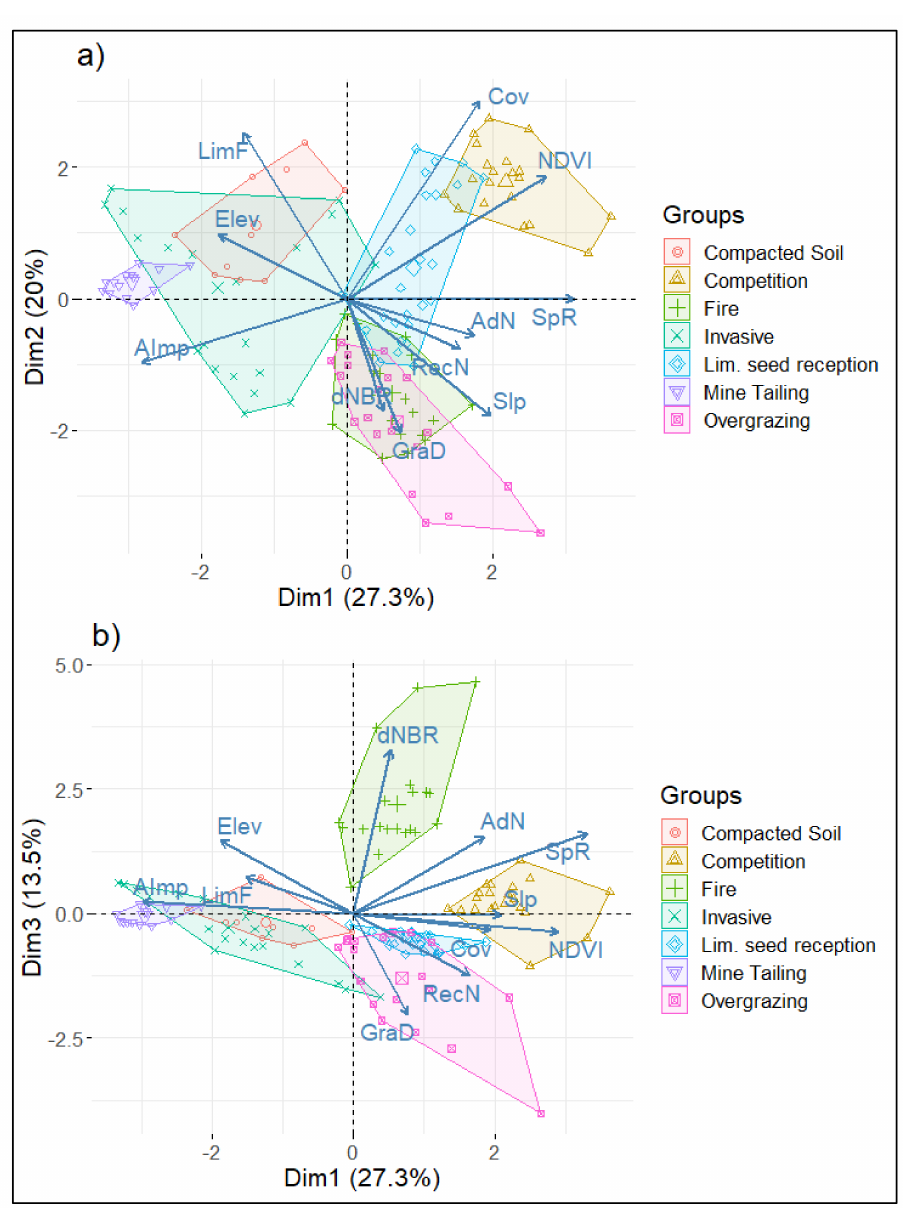
Figure 2. PCA groups’ classification: ( a ) dimensions 1 and 2, ( b ) dimensions 1 and 3. Group names correspond to those in Table 1. SpR : focal species richness, AdN : No. of adults and sub-adults, RecN : No. of saplings and juveniles, LimF : limiting factors, AImp : anthropogenic impacts, Cov : tree canopy cover, Elev : elevation in meters above sea level, Slp : slope expressed as degrees, dNBR : differenced normalized burn ratio, NDVI : normalized difference vegetation index, GraD : overgrazing